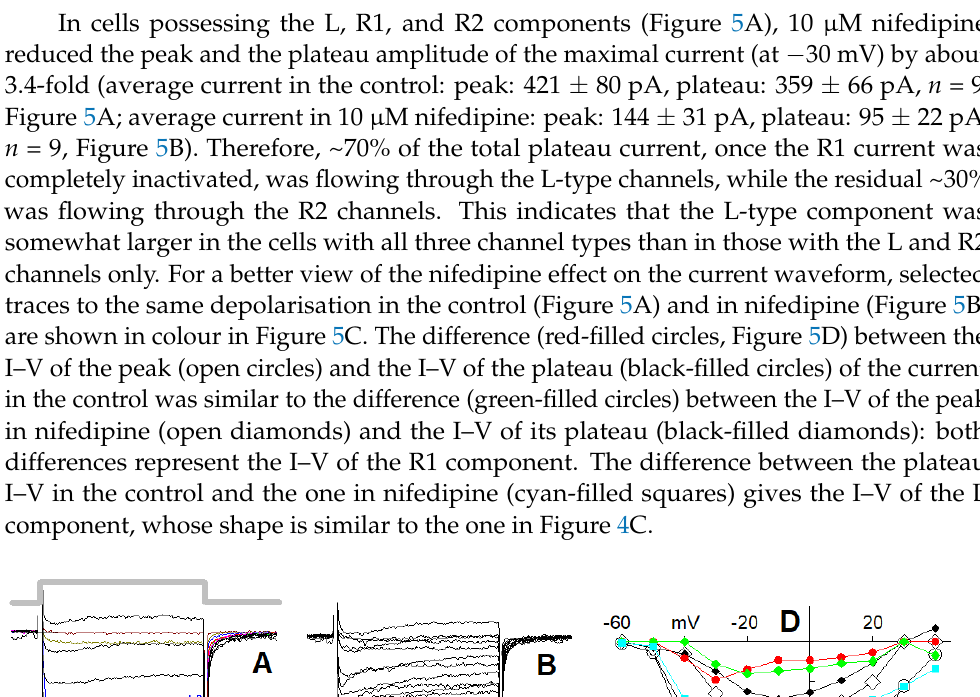
Figure 4. Effect of nifedipine on the L + R2 Ca 2+ current elicited by depolarisations in 4 mM Ca 2+ . ( A ) Ca 2+ currents evoked by the I–V protocol (whose timing is indicated by the thick grey line that also applies to panel ( B )) in a cell displaying the L and R2 components; scales of ( A ) also apply to ( B ). ( B ) Effect of 10 µ M nifedipine on the currents of the cell in ( A ). ( C ) Steady-state I–V relationships obtained from the tracing in ( A ) (circles) and ( B ) (diamonds); the difference between the two I–Vs is shown in turquoise (squares). Some current traces in ( A ) are coloured with the same code of Figure 2 to better identify them; traces in ( B ) are not coloured because traces were too close.